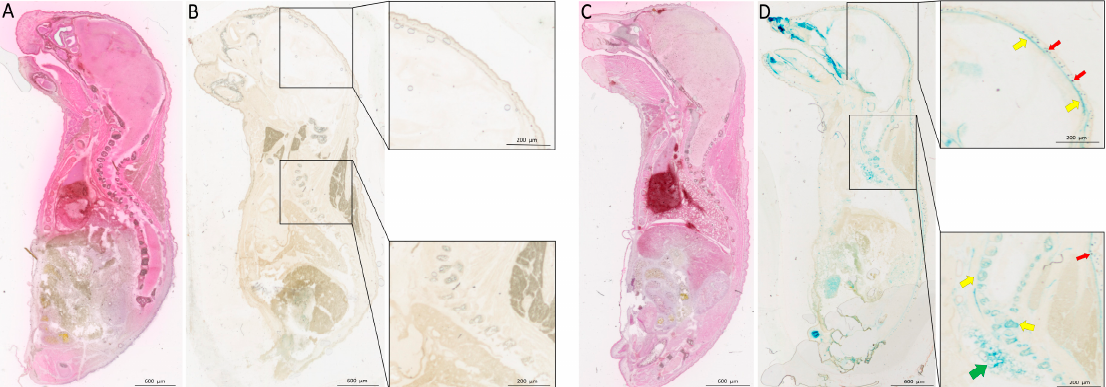
Figure 1. Expression of β -galactosidase (LacZ) in P0 mice. H&E staining shows no abnormalities in Bmp3 − / − mice ( C ) compared to WT ( A ) mice. X-gal staining shows no LacZ reporter protein in WT ( B ), while in Bmp3 − / − mice ( D ) localization of LacZ reporter protein can be observed in bone (yellow arrows), hair follicles (red arrows), and lungs (green arrow). X-gal staining was particularly pronounced in the viscerocranium and the base of the skull.